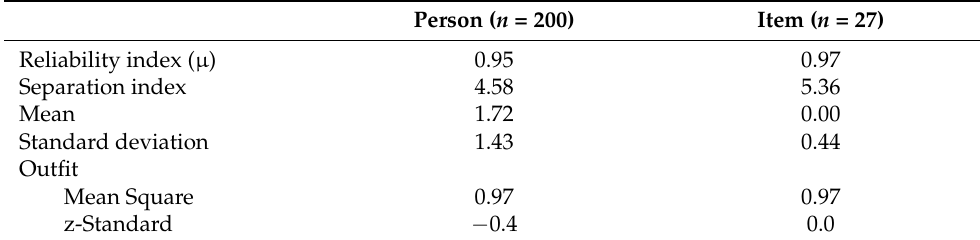
Table 2. Person and item summary statistics.